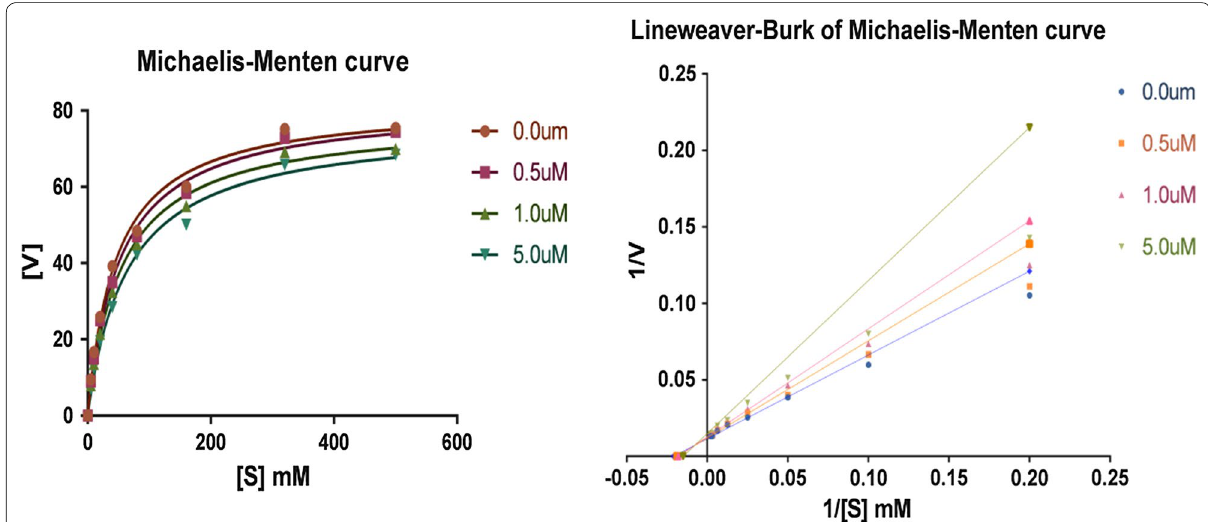
Fig. 4 Lineweaver–Burk plot for oxidation of tyramine by MAO-A in the presence and absence of compound